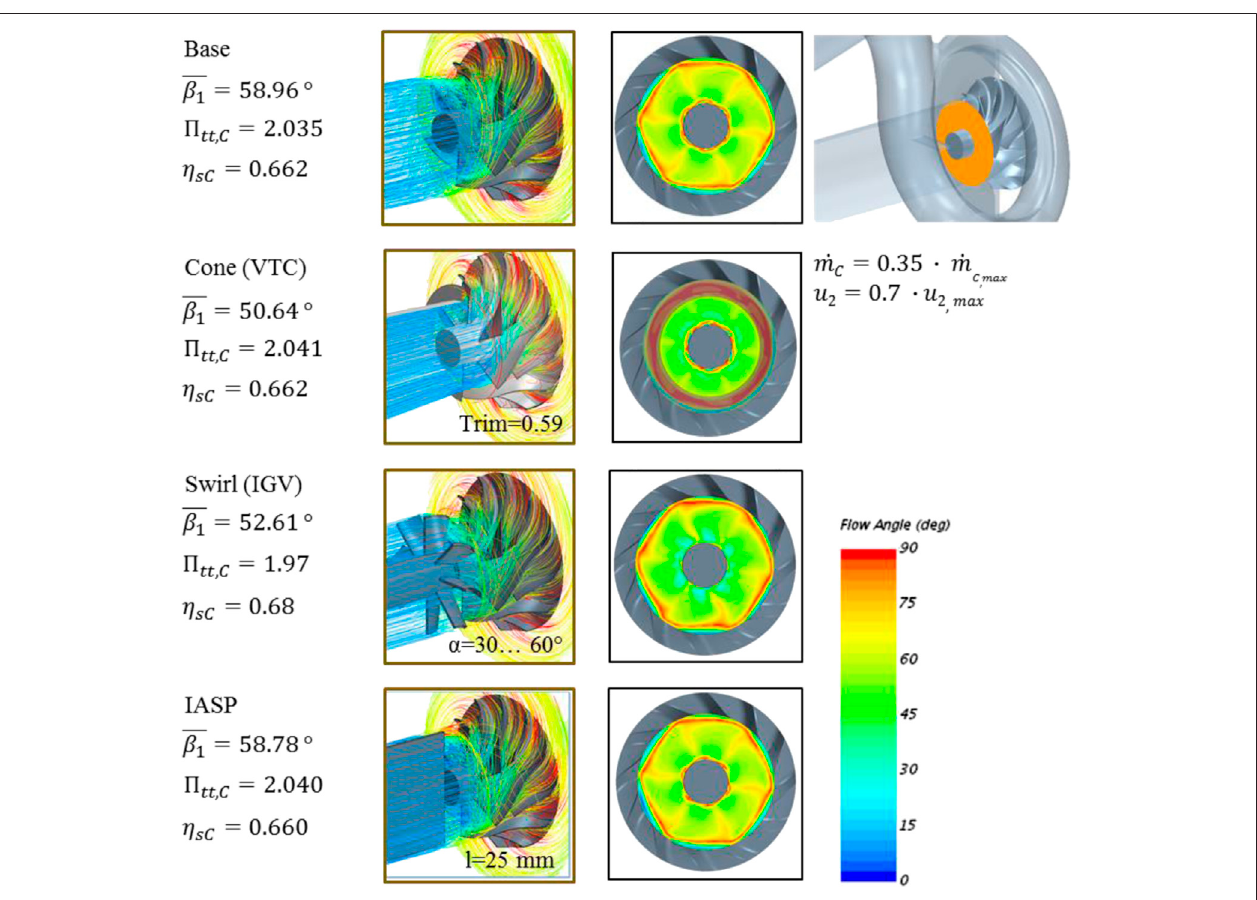
FIGURE 5 | CFD results of base, cone, swirl and